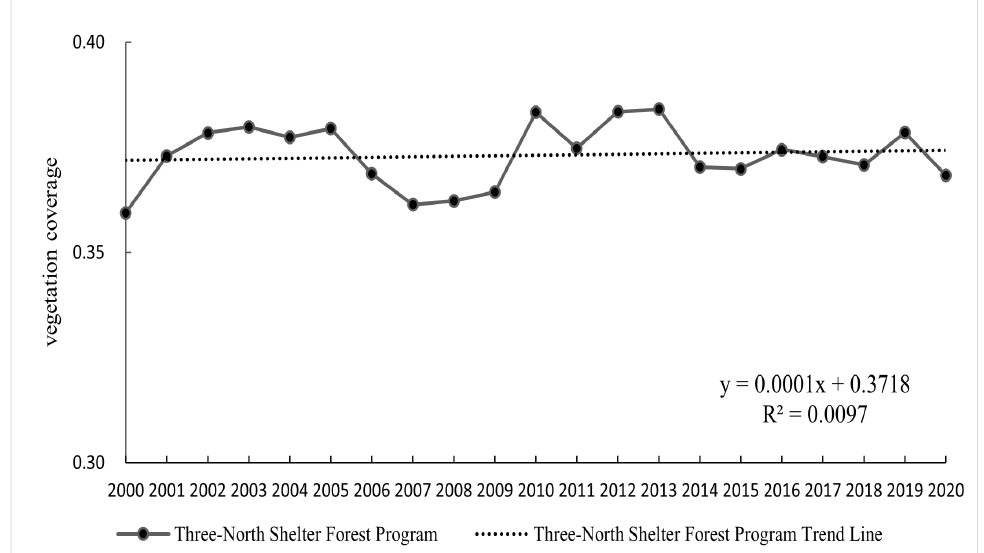
Figure 2. Interannual trends in average FVC in the Three North Protection Forest Project area from 2000 to 2020.